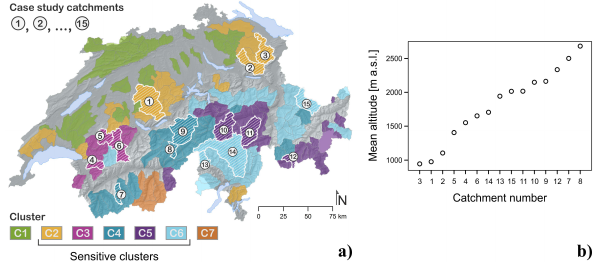
Fig. 1. Spatial (a) and altitudinal (b) distribution of case study catchments. The clustering according to K¨oplin et al. (2012) is dis- played. Out of the seven clusters, C2 to C6 showed the most sensi- tive response to climate change in the study by K¨oplin et al. (2012) and we sampled those five sensitive clusters through three catch- ments each, which results in 15 case studies for further